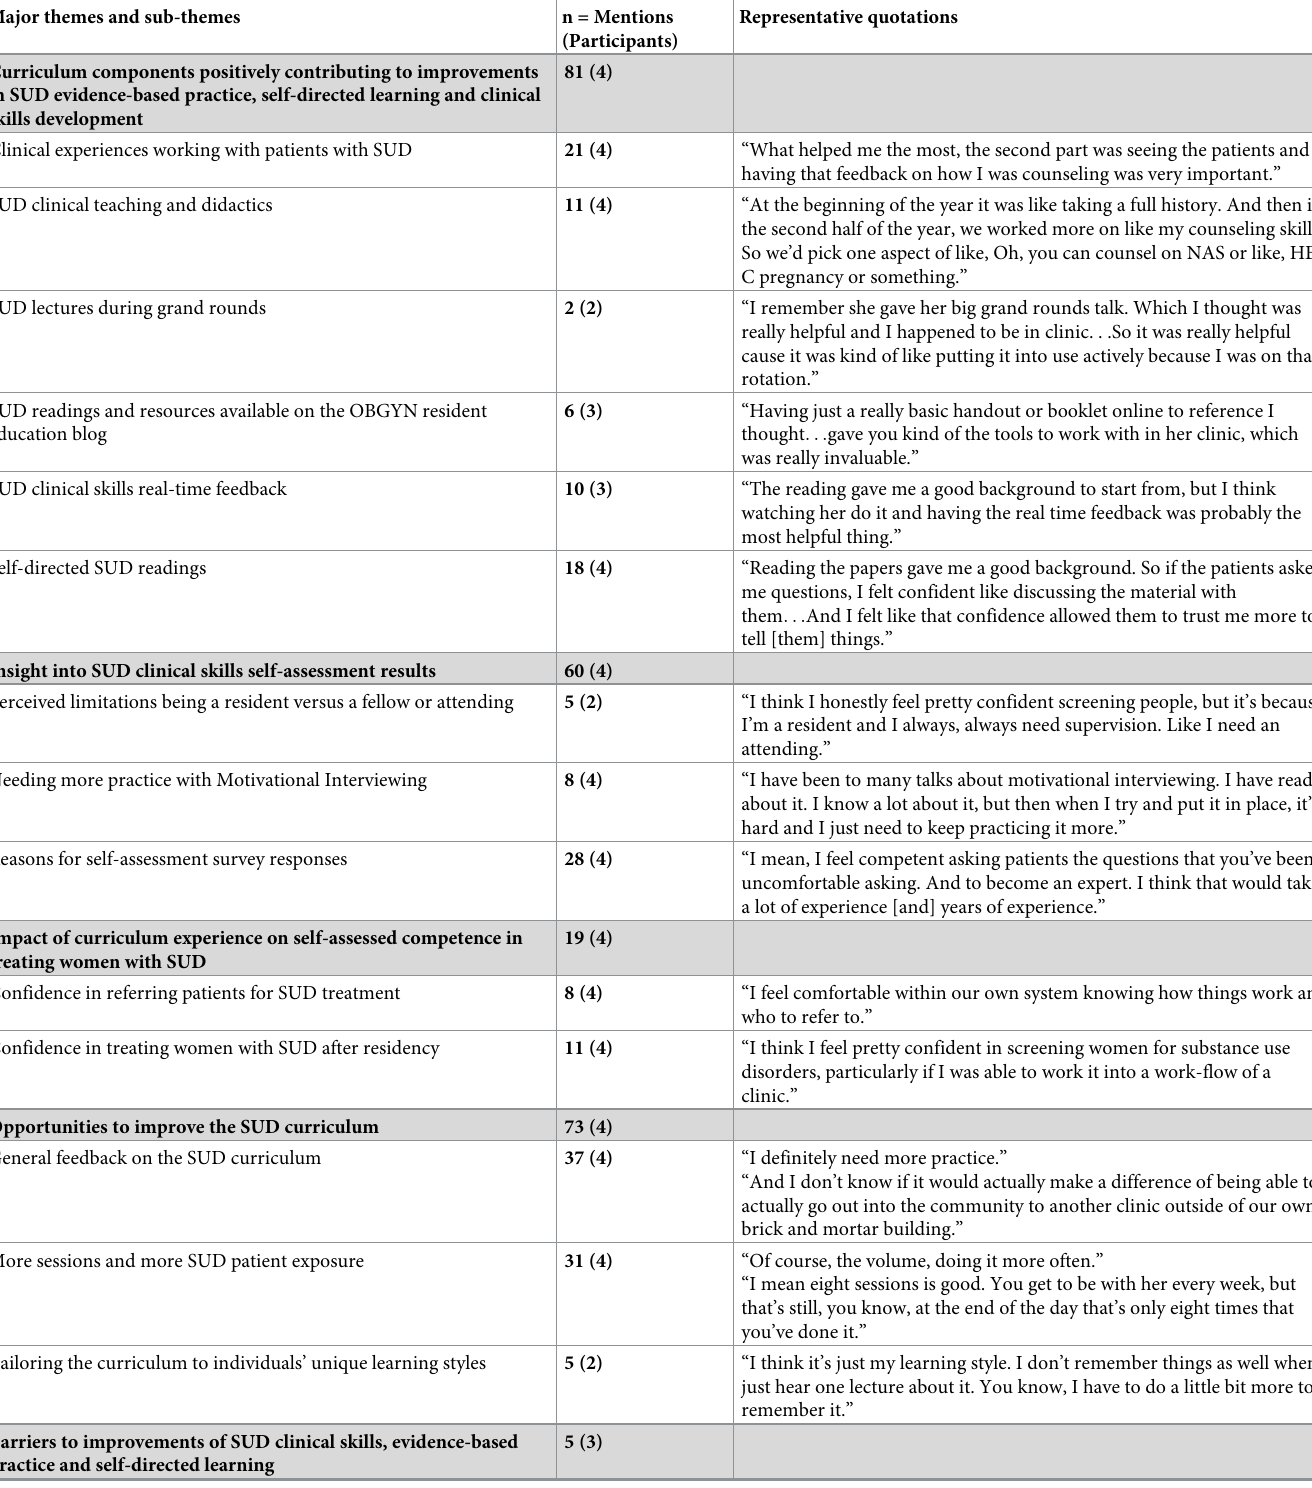
Table 5. Resident interview themes with frequency counts and representative quotations on pilot SUD curriculum feasibility and acceptability (n =